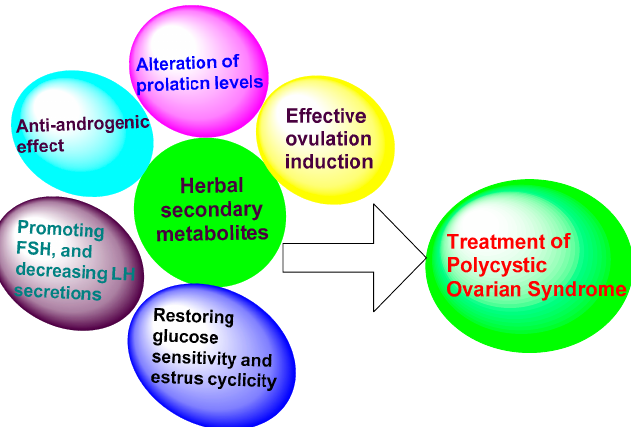
Figure 3. Mechanisms through which different herbal secondary metabolites are active in the treat- ment of PCOS. treatment of